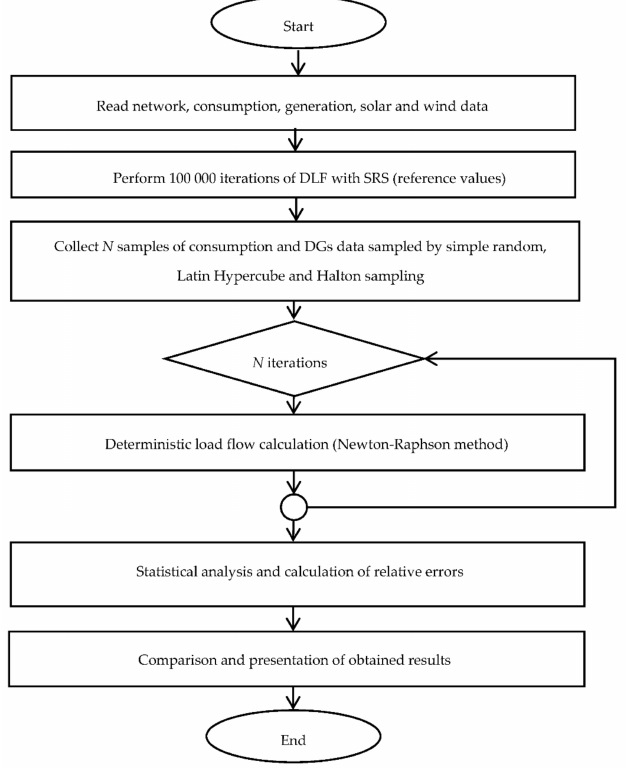
Figure 8. Scheme of probabilistic load flow